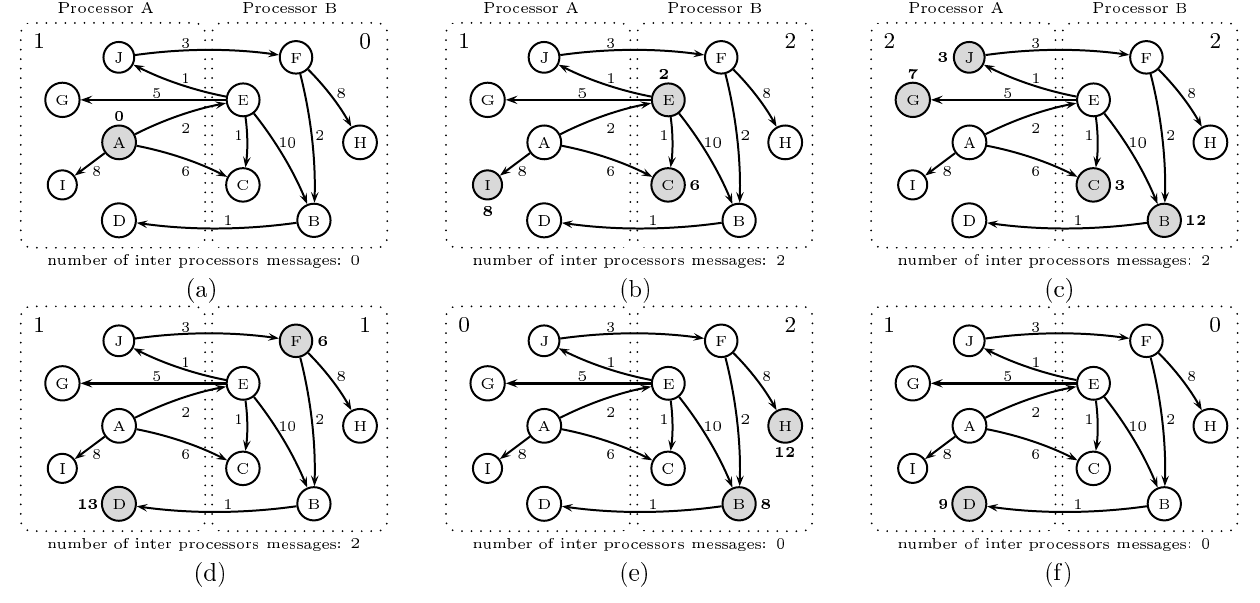
Figure 4. Execution of SSSP on Graph G(10,11) when nodes are randomly